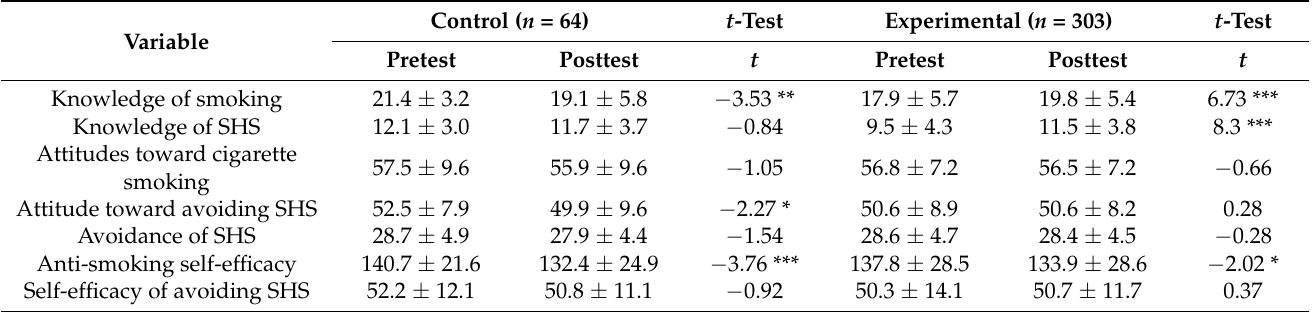
Table 3. Descriptive statistics of each outcome measure in the pretest and posttest.